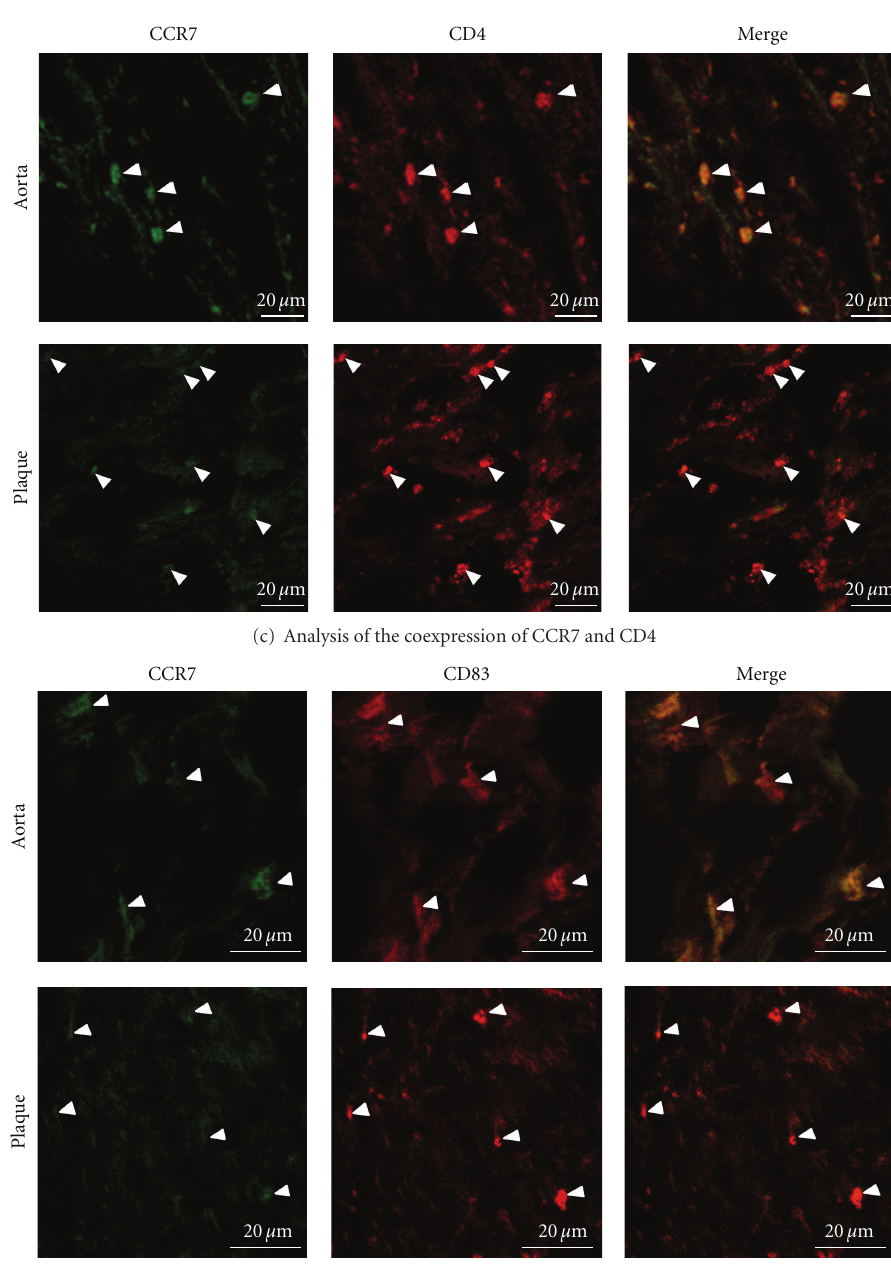
Figure 2: Protein expression of CCL21 and CCR7 on carotid plaque and aortic tissue. (a) Analysis of the CCL21 expressing structures in human aortic tissue. In the upper part the blue staining represents the cell nuclei (DAPI) and the red staining represents CCL21, positive structures ( α -CCL21/6Ckine-Alexa488, pseudocolored). Scale bar 10 μ m. To examine the vessel wall as CCL21 expressing structures